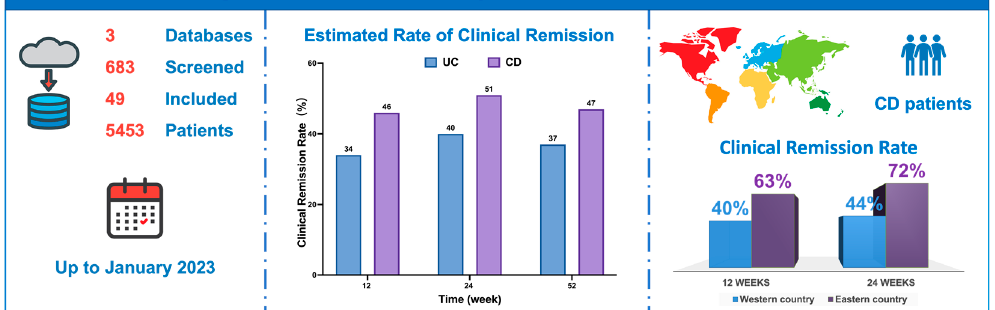
Figure 3. Clinical remission rates significantly differed among CD patients enrolled in Western and Eastern countries. Based on the data obtained from 49 real-world observational studies, this meta-analysis determined the estimated rates of IBD patients administered UST for clinical remission at 12 weeks, 24 weeks and 48 weeks before January 2023. Especially among CD patients, there was a huge difference in clinical remission between Western and Eastern countries.